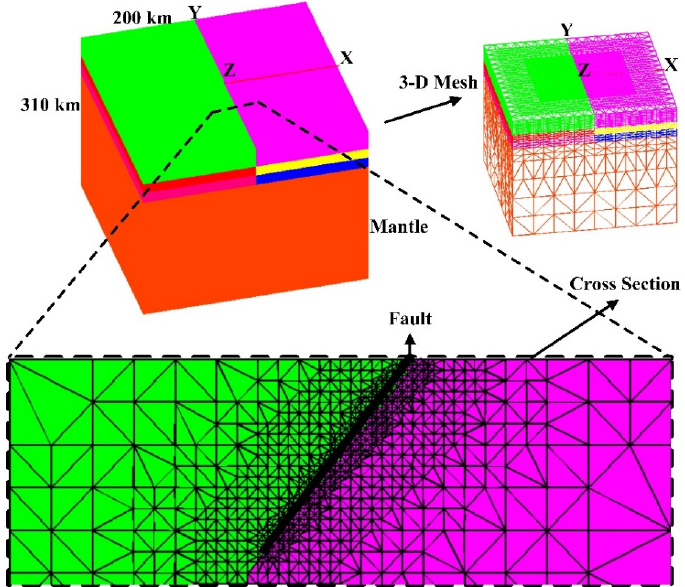
Figure 3. The FEMs of the 6 October 2008 M W 6.3 Dangxiong earthquake. The fault of the Dangxiong earthquake embedded into 3-D FEM with a flat surface and a dimension of 200 × 200 × 310 km. Black solid line located at the junction of the two mediums indicate the location of the fault.